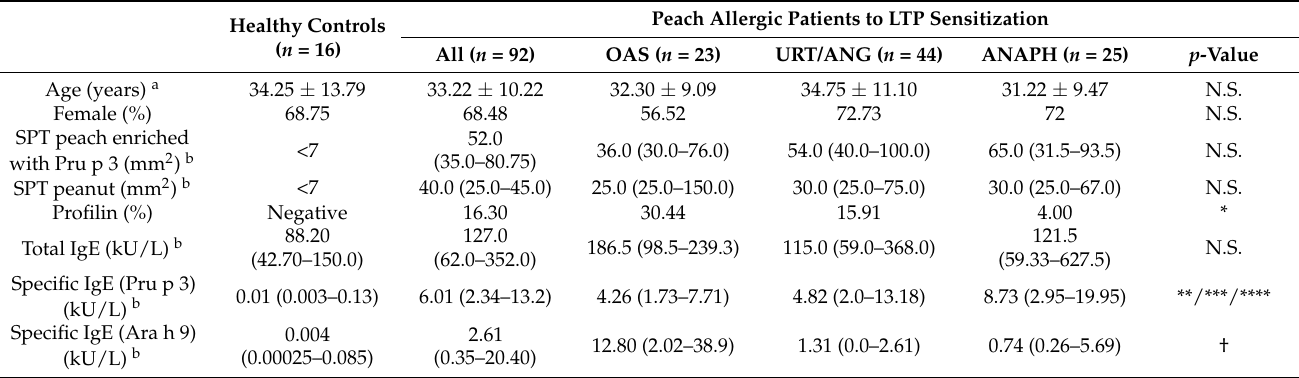
Figure 1. Flow chart of the patient classification . Nonresponder patients in BAT, and nonsensitized and nonallergic individuals were excluded from the study. The remaining patients were classified according to clinical history into three severity groups: oral allergy syndrome (OAS), urticaria/angioedema (URT/ANG), and anaphylaxis (ANAPH). Furthermore, these peach-allergic patients were divided into patients allergic to peach (Group A) and individuals allergic to peach and peanut (Group B). These groups of patients were used to compare them in clinical and BAT parameters terms. Table 1. Clinical and demographic characteristic of study population and clinical groups.